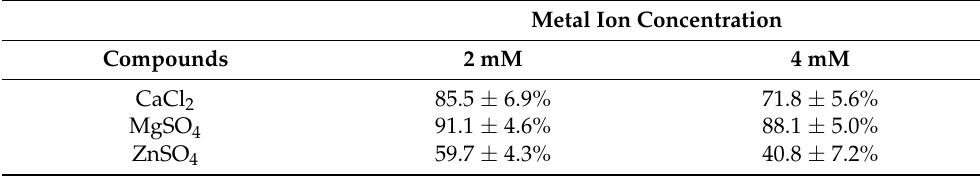
Table 1. Effect of metal ions on the proteolytic activity of SK1-1.